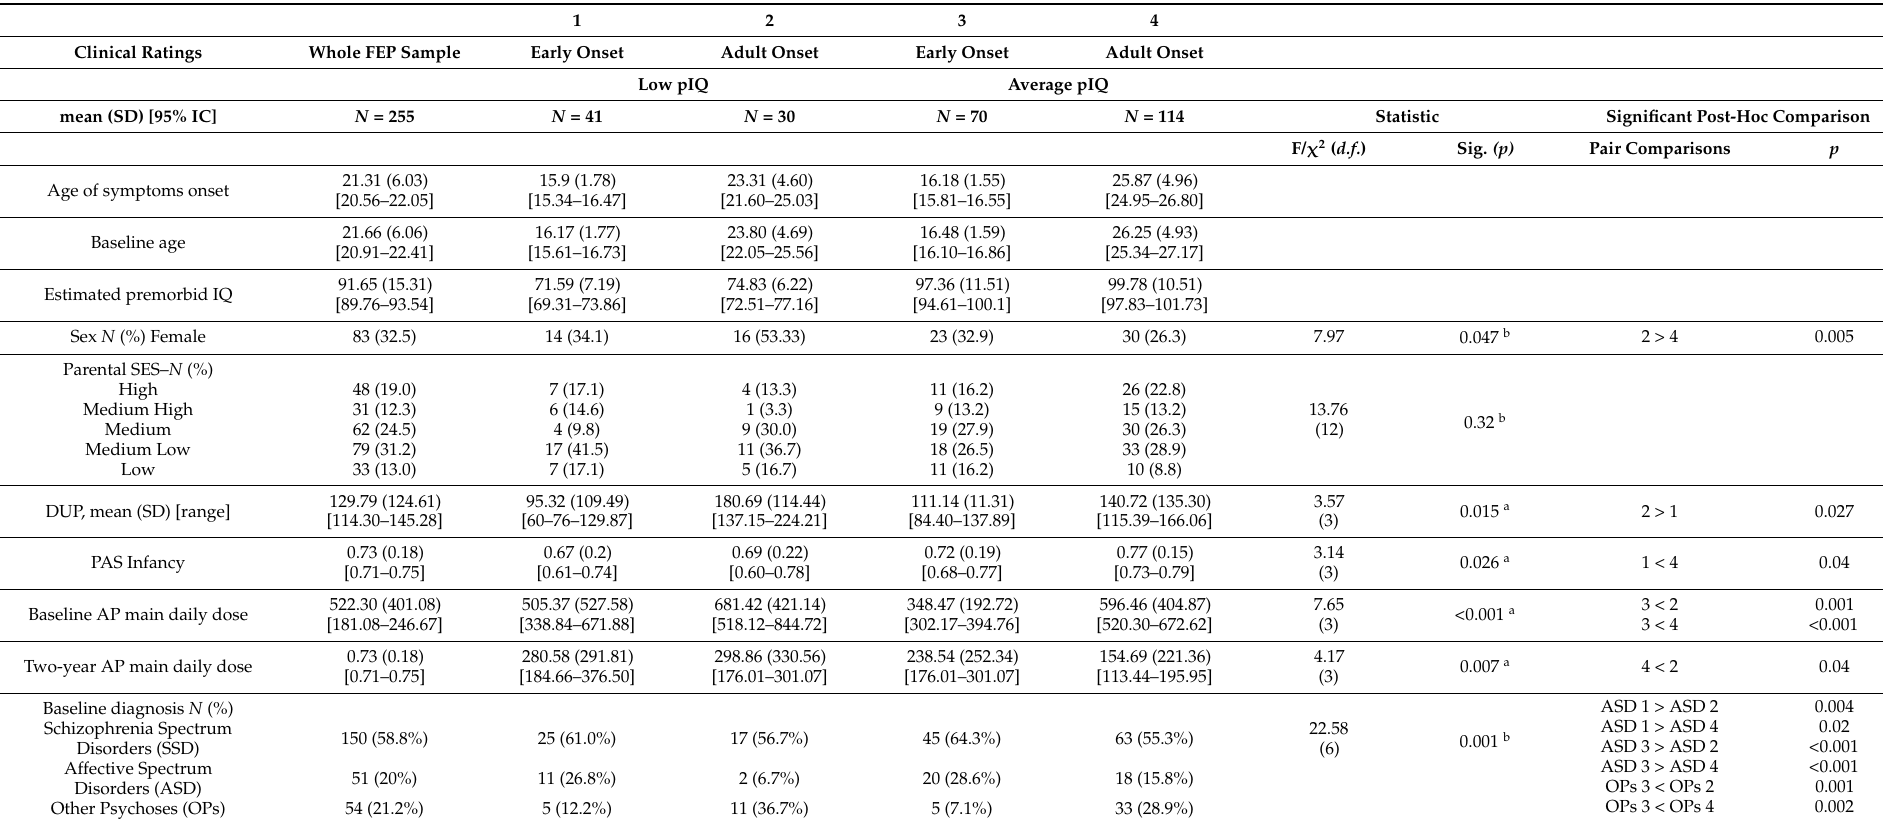
Table 1. Demographic characteristics of the whole sample of individuals who have experienced a first episode of psychosis and by subgroups classified as: early-onset with low-pIQ, adult-onset with low-pIQ, early-onset with average-pIQ, early-onset with average-pIQ.